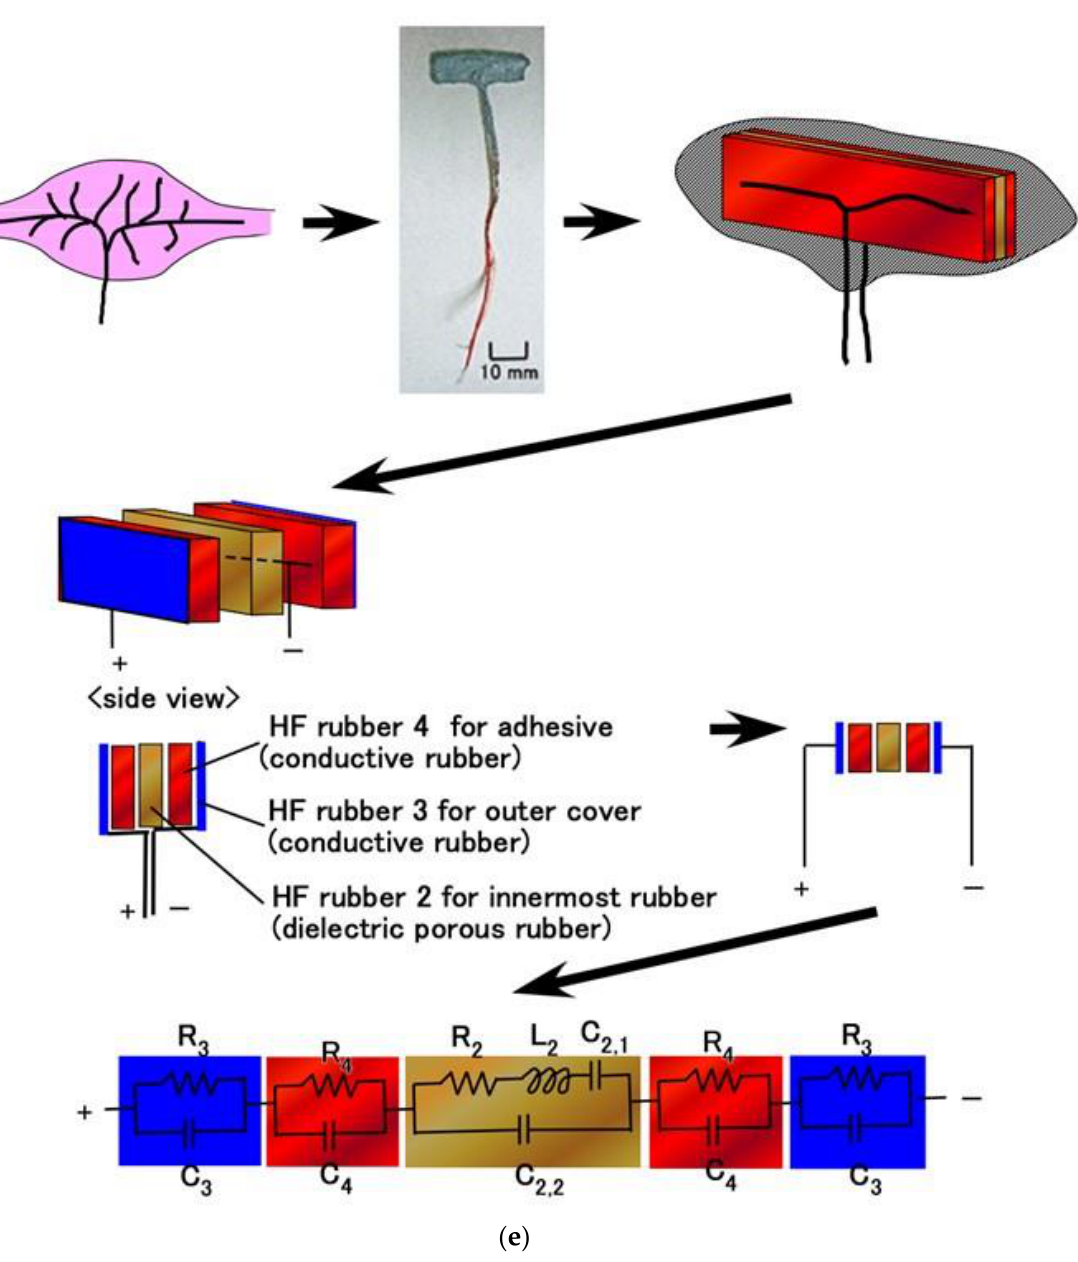
Figure 5. Schematic of our cutaneous mechanoreceptor, images of the fabricated mechanoreceptor, schematic of the fabricated mechanoreceptor, structure of the fabricated mechanoreceptor, equivalent electric circuit: ( a ) free nerve endings; ( b ) Krause end bulbs; ( c ) Meissner corpuscles; ( d ) Pacinian corpuscles; ( e ) Ruffini endings.